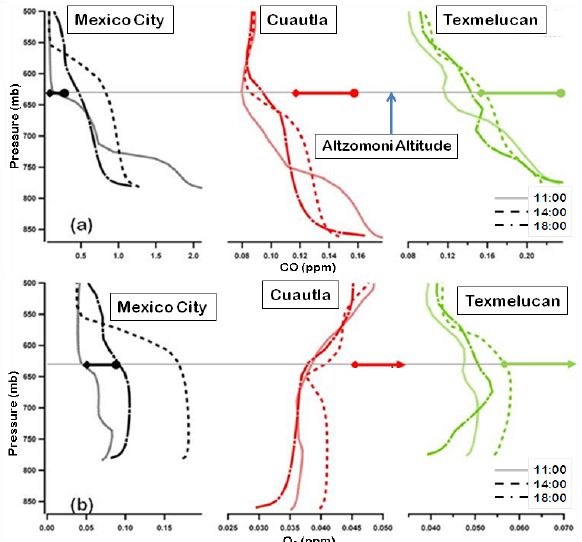
Fig. 10. The simulated vertical profiles displayed here are for (a) CO and (b) O 3 concentrations at three locations upwind of Alt- zomoni when the winds are from the WNW (black curves, Mex- ico City), SW (red curves, Cuautla) and E (green curves, Texmelu- can) at three time periods. The 1100 periods (light solid curves) are when the RML is arriving at Altzomoni, 1400 periods (dark dashed curves) are when the CO and O 3 are approximately maxima and 1800 periods (dark solid curves) are when the RML is beginning to collapse. The horizontal, solid bars at the pressure level of Alt- zomoni connect the simulated (diamond) and measured (solid cir- cle) concentrations at Altzomoni. The arrow signifies that the mea- sured concentration is larger than the maximum on the